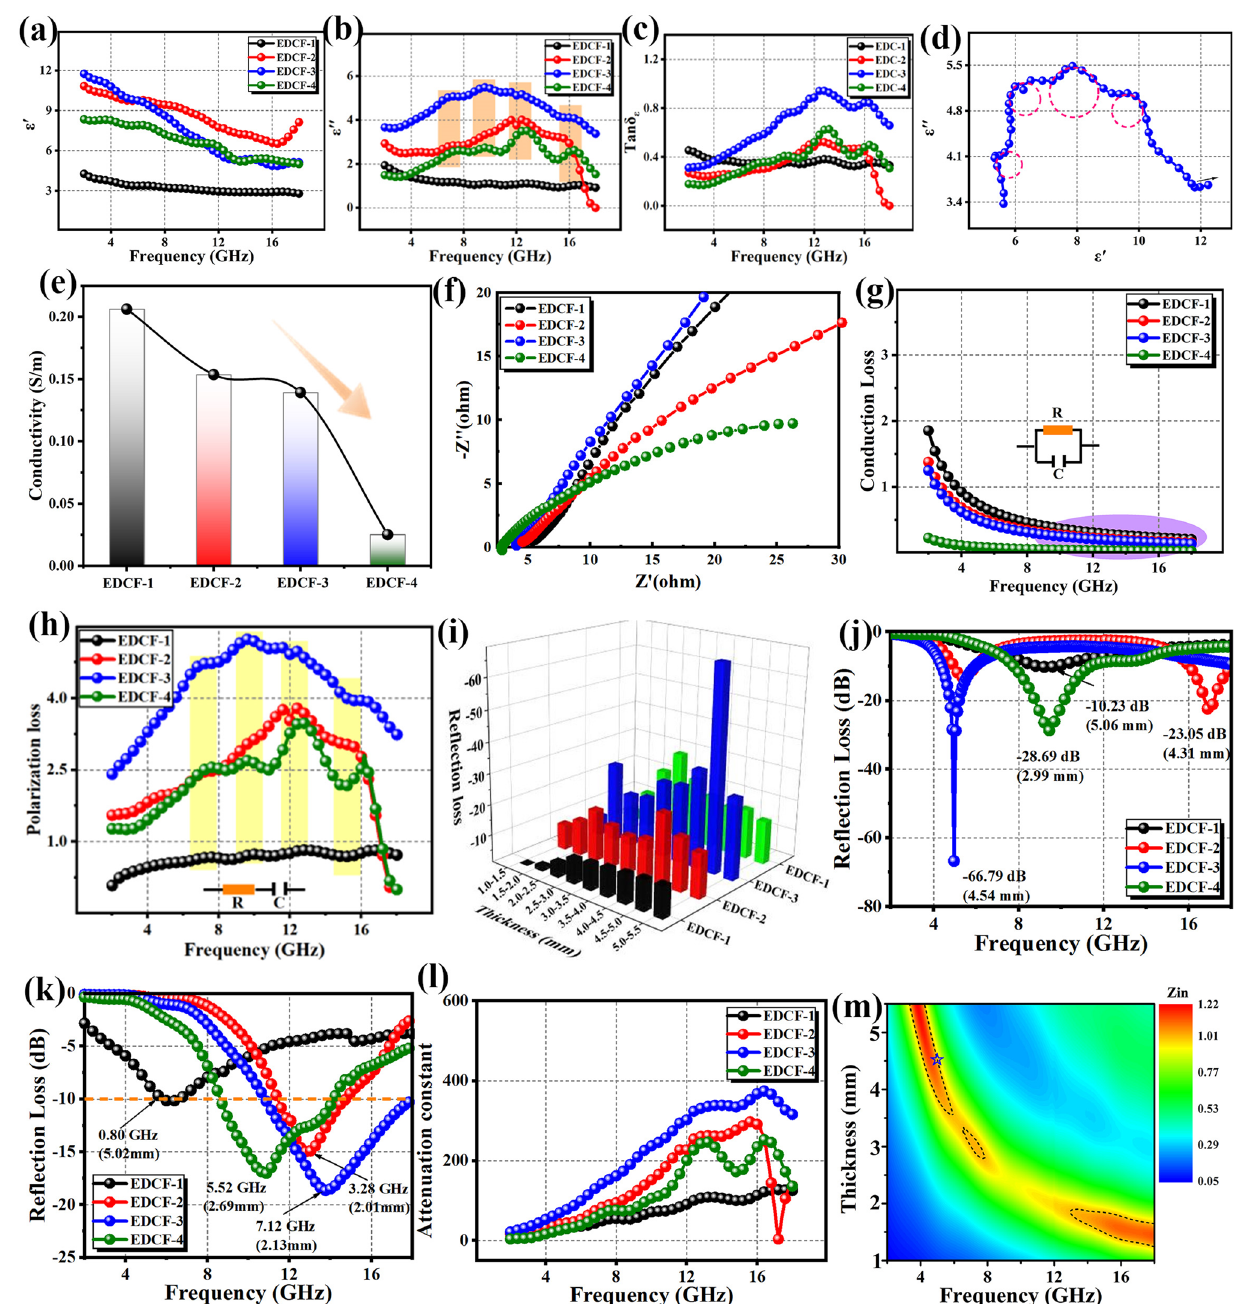
Fig. 3 a The real part and b the imaginary part of the complex permittivity for various EDCF samples; c tangent of dielectric loss of the EDCF samples; d Cole–Cole curve of EDCF-3; e conductivity; f EIS spectrum of EDCF samples; g conduction loss values and h polarization loss val- ues of various EDCF samples versus frequency; i comparison of the RL values of various EDCF samples at different thickness; j comparison of the minimum RL curves and k the widest EAB curves of different EDCF samples at their respective optimum thickness; l attenuation constant of EDCF samples; m impedance matching of